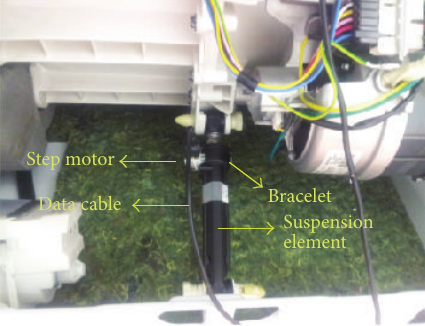
Figure 5: Semiactive suspension element.